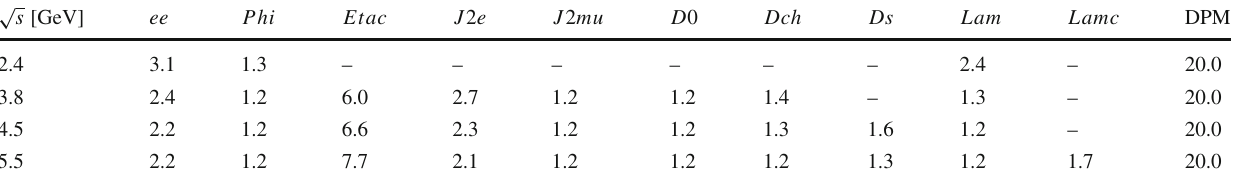
Table 3 Numbers of simulated events of each physics channel at each energy, given in million events. The dashes mark the cases, where the reaction is energetically not possible √ s [GeV]